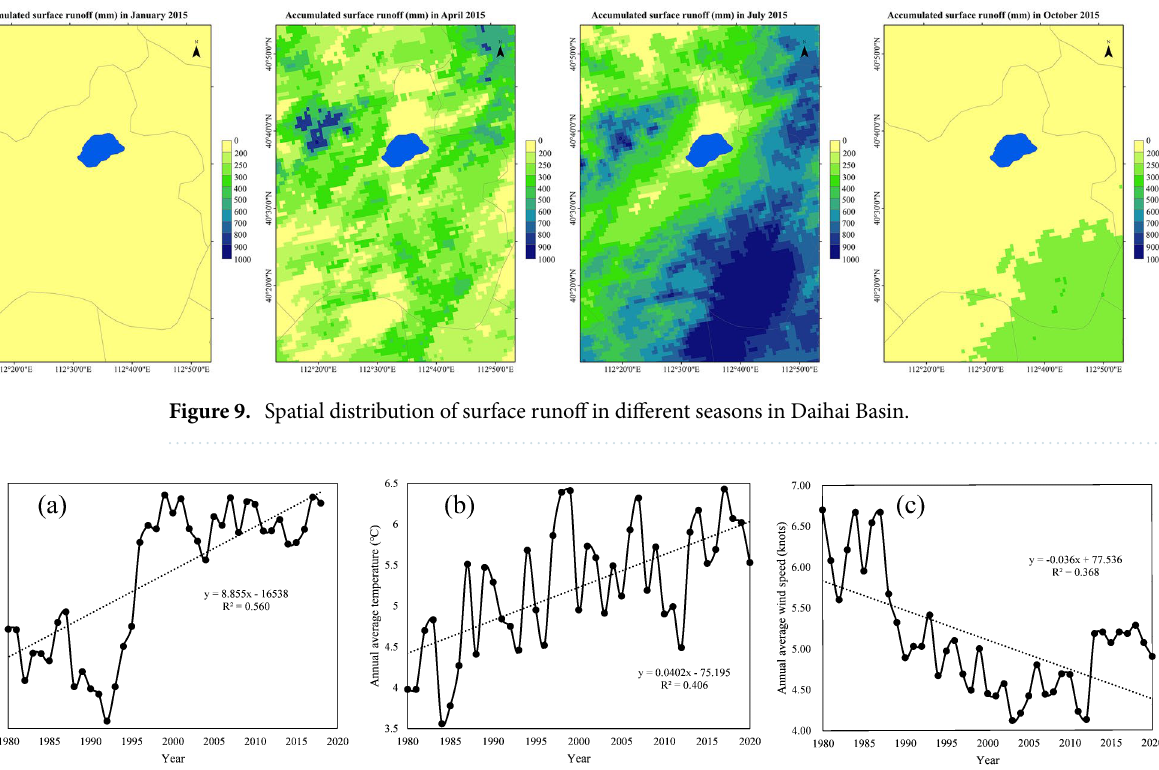
Figure 10. Perennial ( a ) evaporation ( b ) annual average temperature ( c ) annual average wind speed change in Daihai